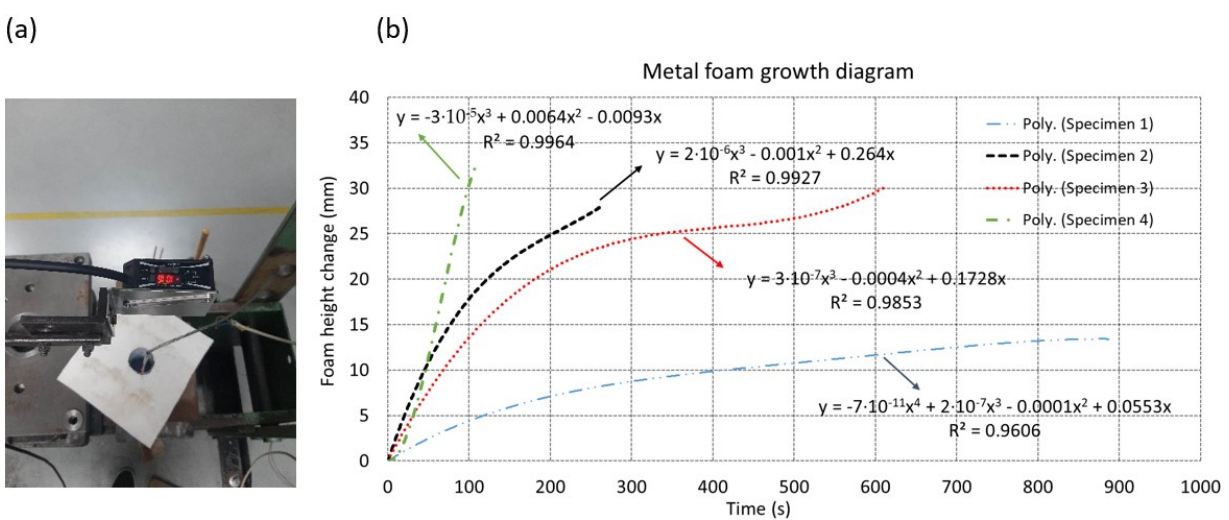
Figure 1. ( a ) Metal foam growth measurement. ( b ) Metal foam growth versus time for different foaming parameters. Table 2. Design of experiments and properties of chip-based aluminum foams. Level of Exp.